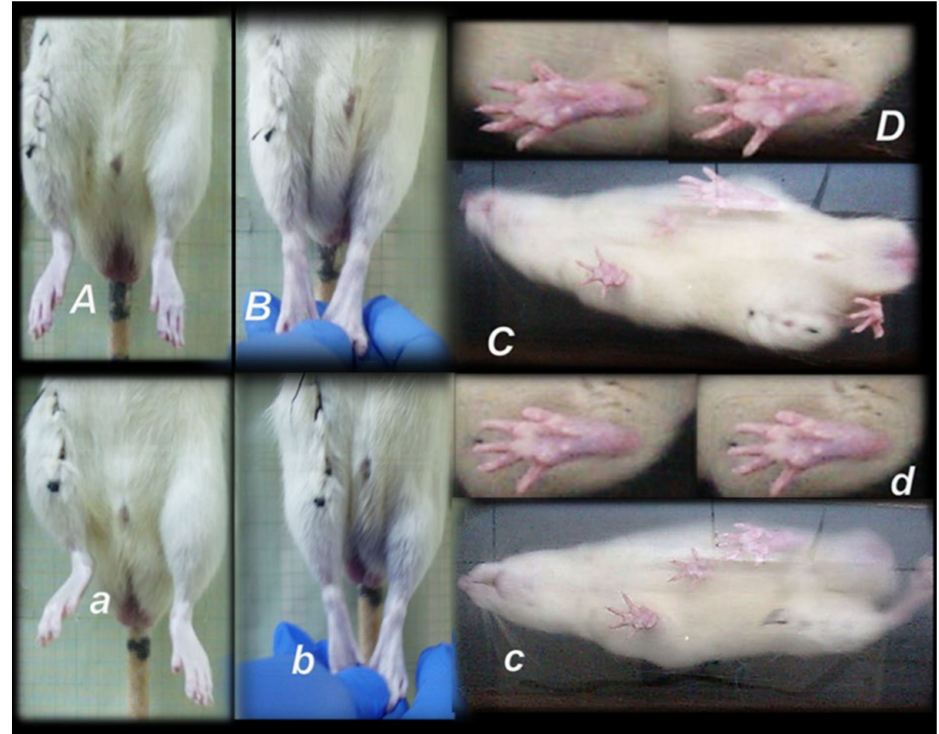
Figure 5. Illustrative presentation of leg contracture, day 3, (presentation (controls), and counteraction (BPC 157)) in awake rats, held upright, markedly affecting the walking presentation (camera positioned below the running way). Controls may exhibit prominent spontaneous injured leg contracture ( a ), clearly evident upon legs extension ( b ), which were completely absent in BPC 157 treated rats ( A , B ) and while walking (three standing point position) foot sliding backward as a sudden jerk of the limb towards the back at the initiation of the swing phase ( c ) (see also Figure 4, b ) and consistently less footprinting due to disturbed ankle-knee synergy ( d ), unlike presentation of the walking ( C ) and footprinting ( D ) in BPC 157 rats close to